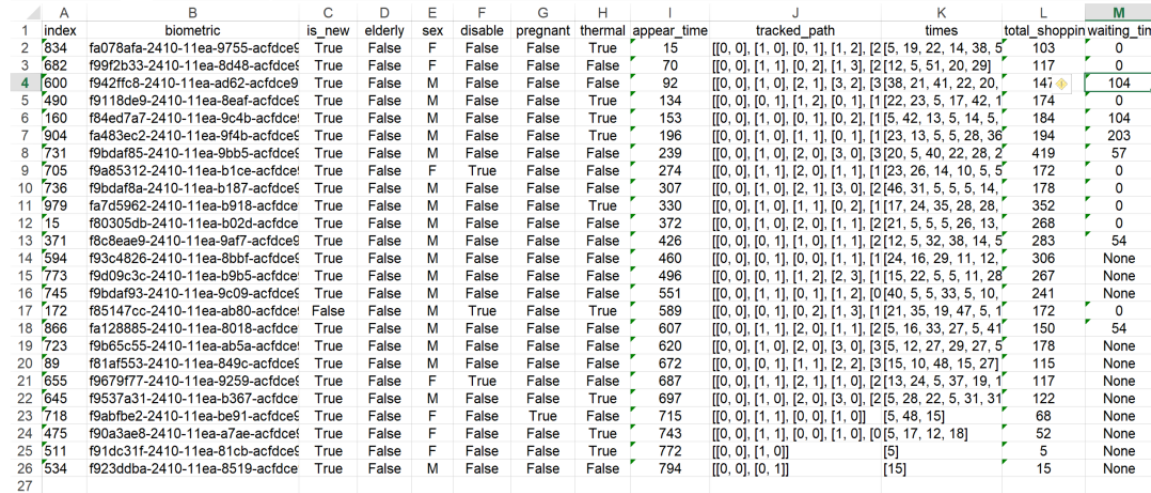
Figure 14. Basic simulation data related to clients.